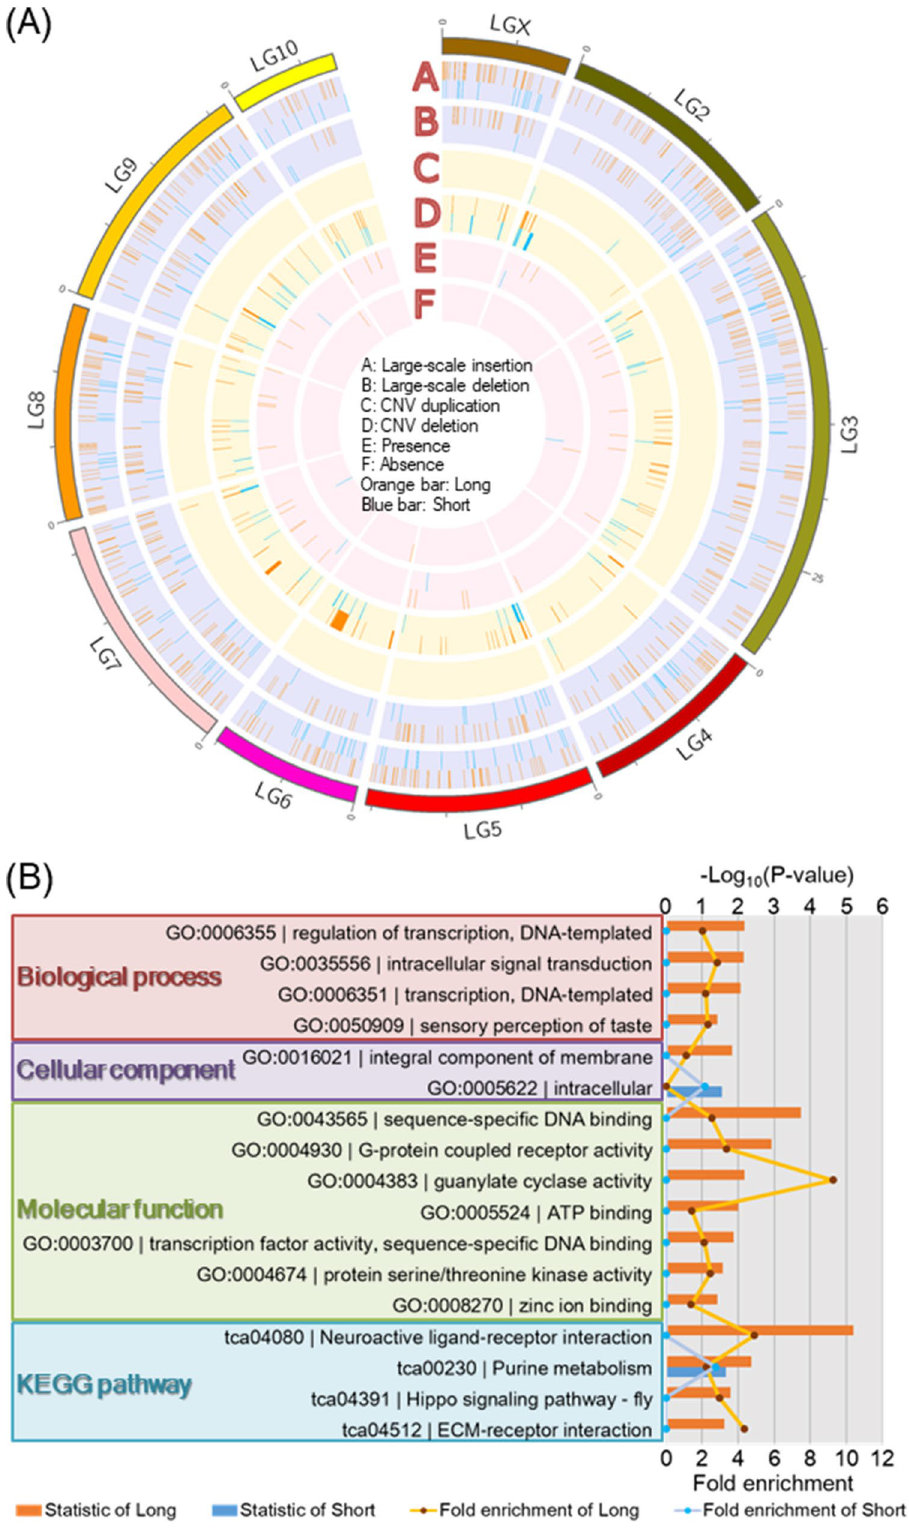
Figure 5. Structural variations on each linkage group in long and short strains ( A ). The circos plot is drawn using Circos (version 0.69-9, http:// circos. ca/). Structural variations include large-scale insertion and deletion, CNV duplication and deletion, and presence and absence of variation. The long and short strains are indicated by orange and blue lines, respectively. GO and KO terms are from function of genes with variants ( B